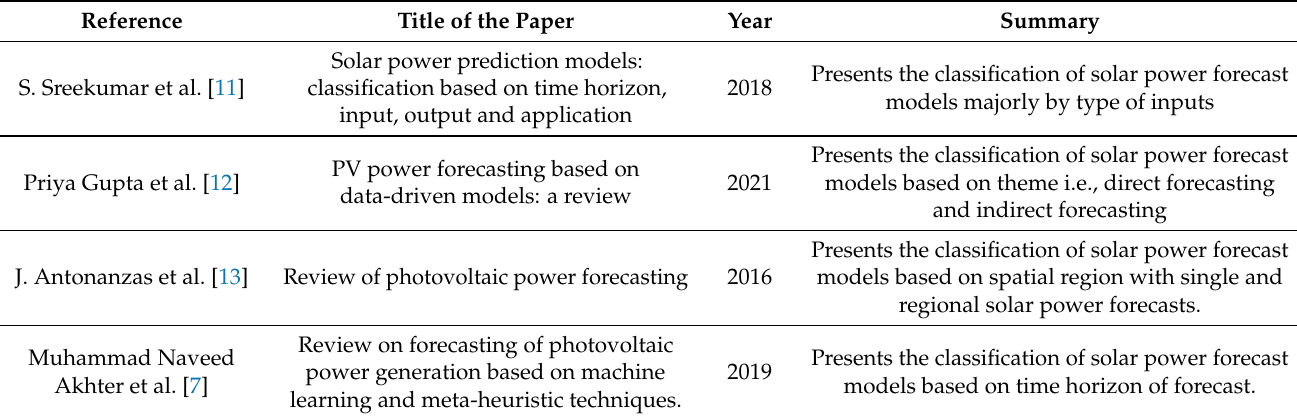
Table 1. Classification survey of solar irradiance and power forecasting